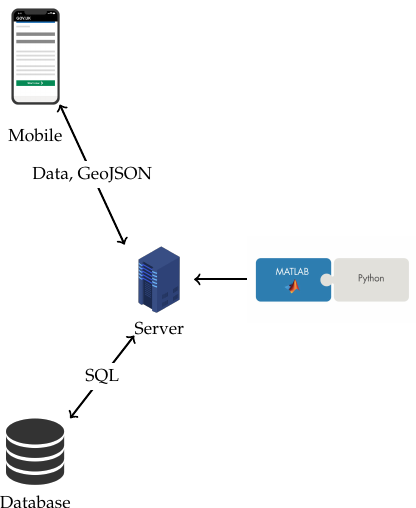
Figure 3. Software architecture for manual collection of crop yield samples.